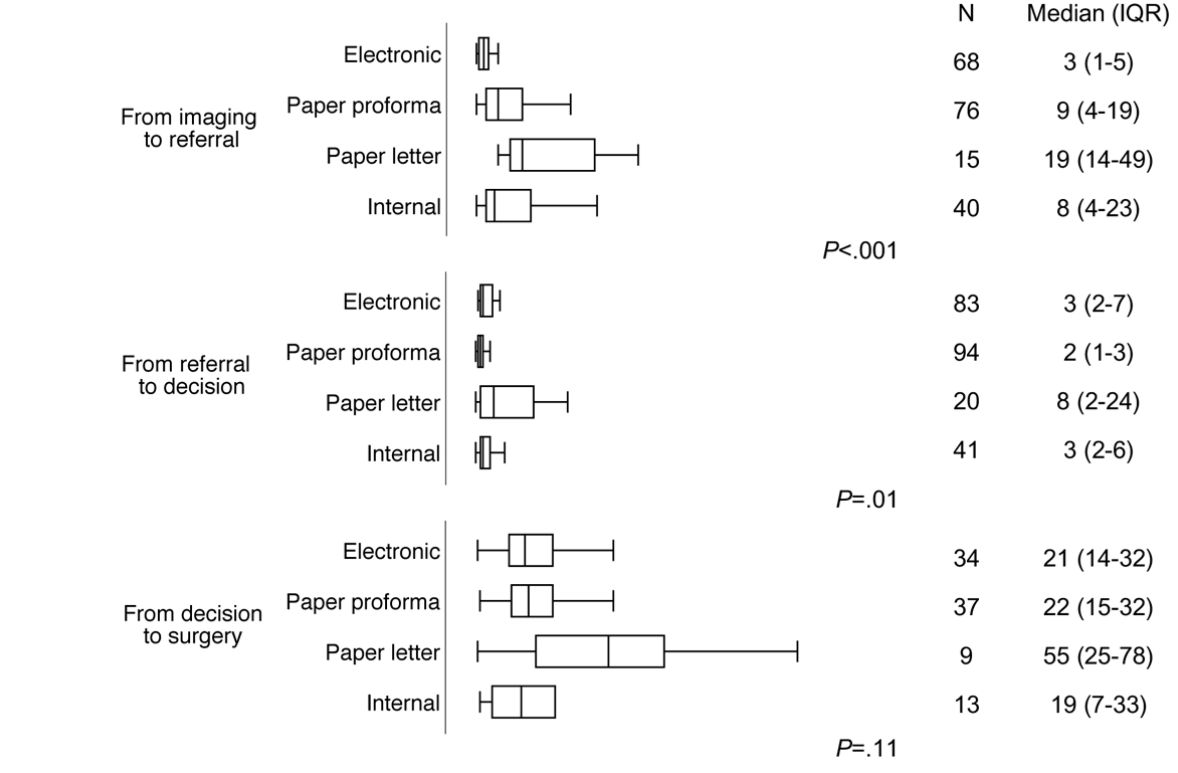
Figure 3. Duration of each phase of the referral pathway, during the 4 months of the study period (April and September of 2016 and 2017). Time from imaging to referral excludes 36 patients with missing date of diagnostic imaging, 4 patients with their imaging carried out after their referral, and 2 patients whose available imaging was older than 6 months before the referral. Values outside the whiskers (more than 1.5 times the IQR from the upper and lower quartiles, respectively) are not plotted. Patients with nonstandard (initially done as emergency neurosurgery referrals) or unknown referral source are not plotted (n=10). Internal refers to intrahospital referrals within the study center using the hospital’s electronic records